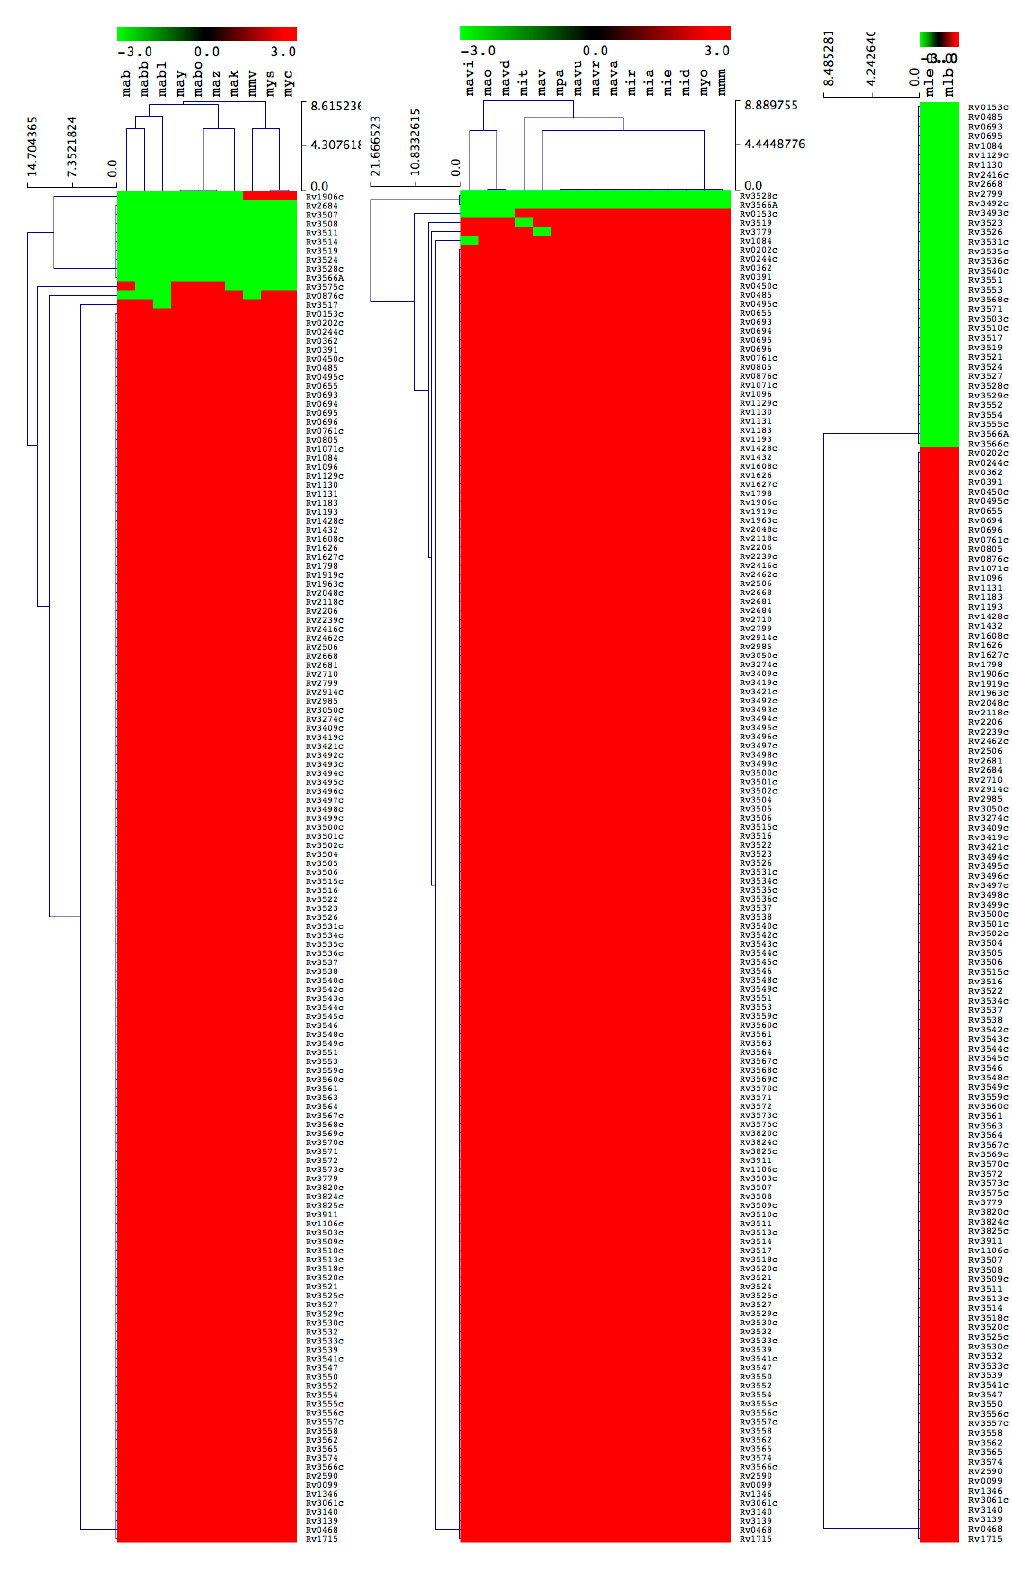
Figure 5. Heatmap of presence or absence of 151 cholesterol catabolic genes/proteins in 10 M. chelonae-abscessus complex species (left panel), 15 MAC species (center panel) and 2 Mycobacterium species causing leprosy (right panel). The data have been represented as –3 for gene absence (green) and 3 for gene presence (red). The 10, 15 and 2 mycobacterial species are represented on the horizontal axes (see Table 3 for species codes) with the 151 genes/proteins on the vertical axes.